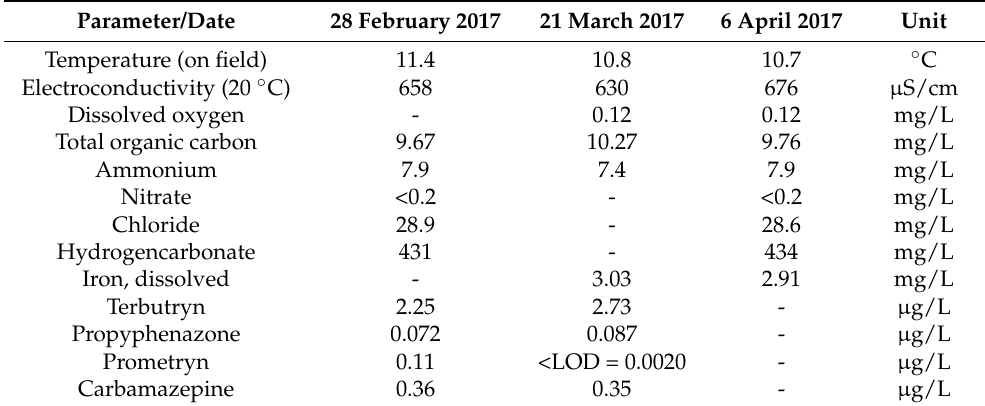
Table 3. Selected analysis results for grab samples collected at the highly polluted sampling site DBP-5 used to test the influence of exposure time.